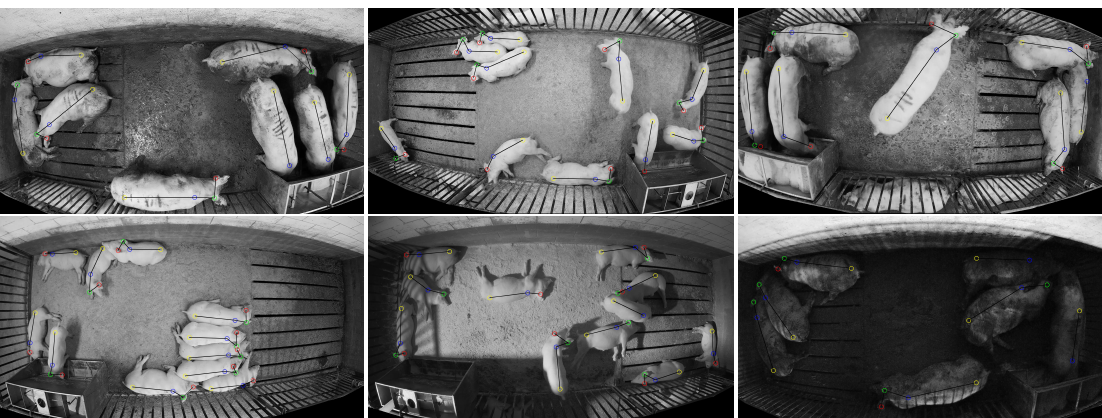
Figure 7. Sample images from the “unseen” portion of the testing set (test:unseen). These images depict environments and lighting conditions not represented in the training set.